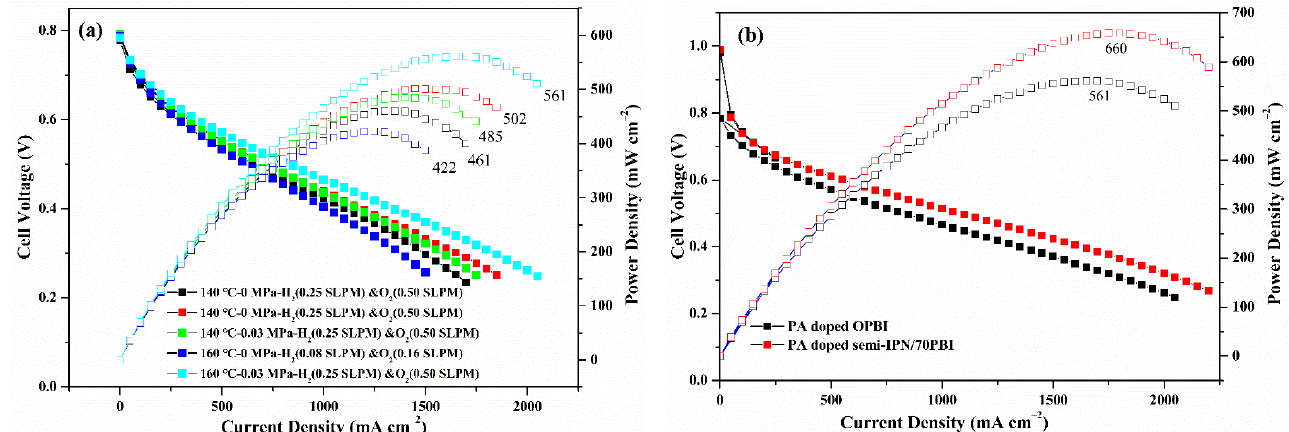
Figure 8. Polarization curves (solid symbols) and power densities (open symbols) of single fuel cells based on the ( a ) PA doped OPBI under different test conditions, and ( b ) PA doped OPBI and semi-IPN/70PBI membranes with flow rates of 250 and 500 mL min − 1 for dry H 2 and O 2 at a backpressure of 0.03 MPa. The thickness of PA doped OPBI and PA doped semi-IPN/70PBI is 65 and 48 μ m, respectively.